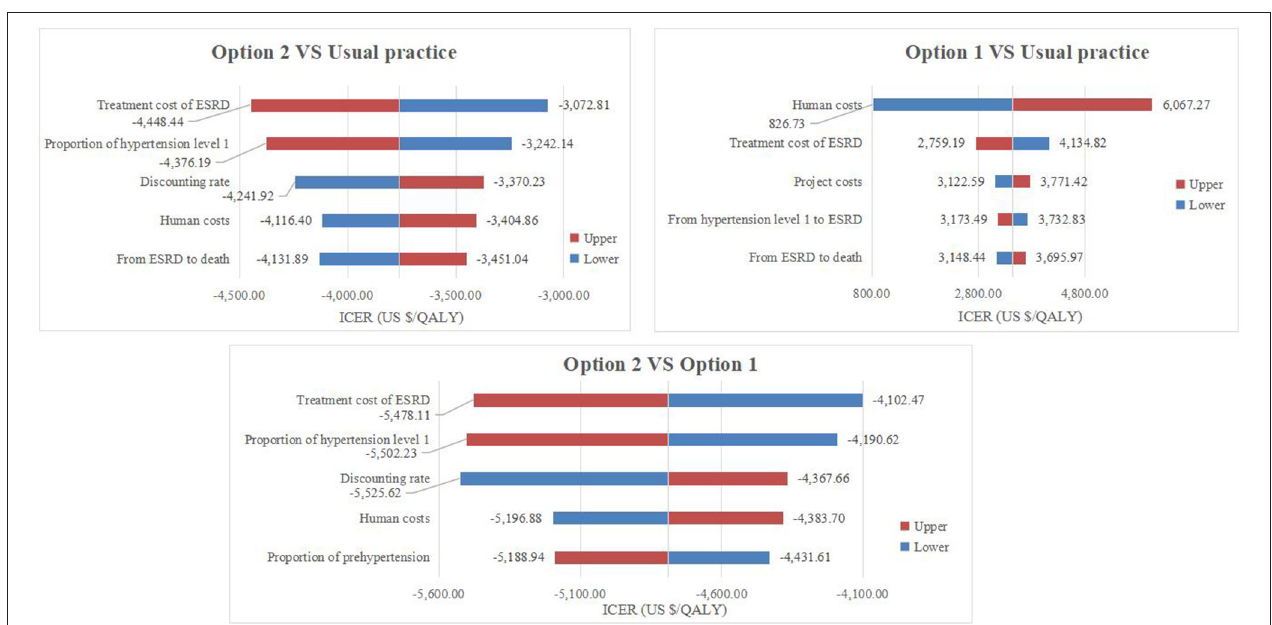
FIGURE 2 | Tornado diagrams of the one-way sensitivity